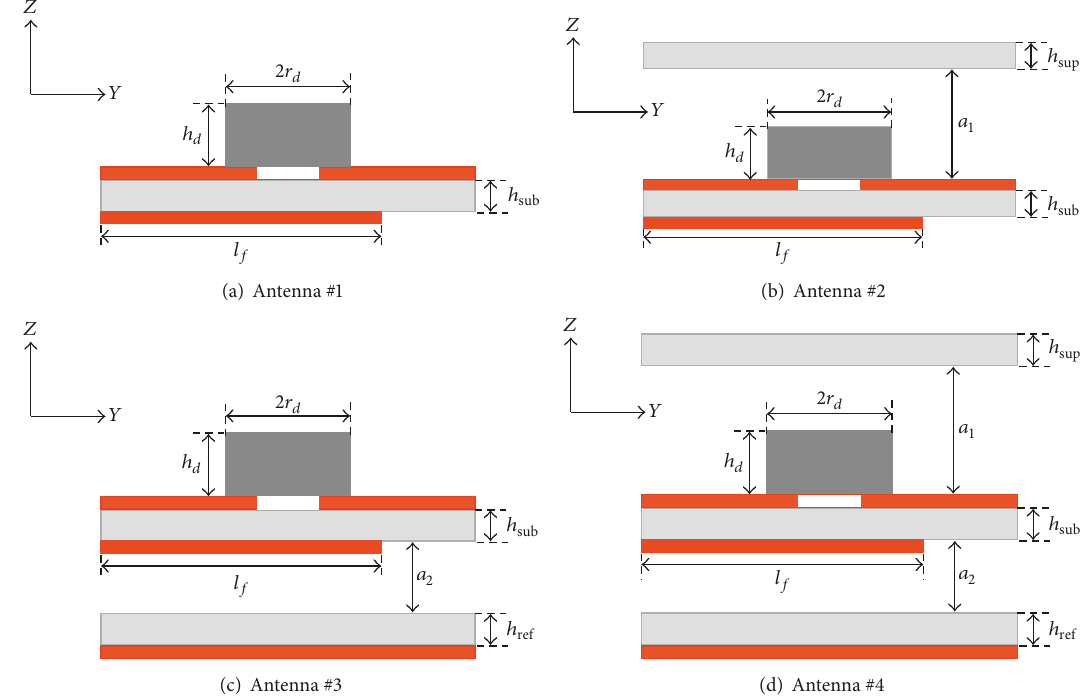
Figure 2: It illustrates the cross-sectional views of four different development stages of the proposed dielectric resonator antenna (antenna design dimensions: ℎ 𝑑 = 𝑟 𝑑 = 0.135𝜆 0 , 𝑙 sub = 𝑤 sub = 1.08𝜆 0 , 𝑙 sup = 1.08𝜆 0 , 𝑤 sup = 0.54𝜆 0 , 𝑙 ref = 𝑤 ref = 1.35𝜆 0 , ℎ sub = ℎ sup = ℎ ref = 0.043𝜆 0 , 𝑙